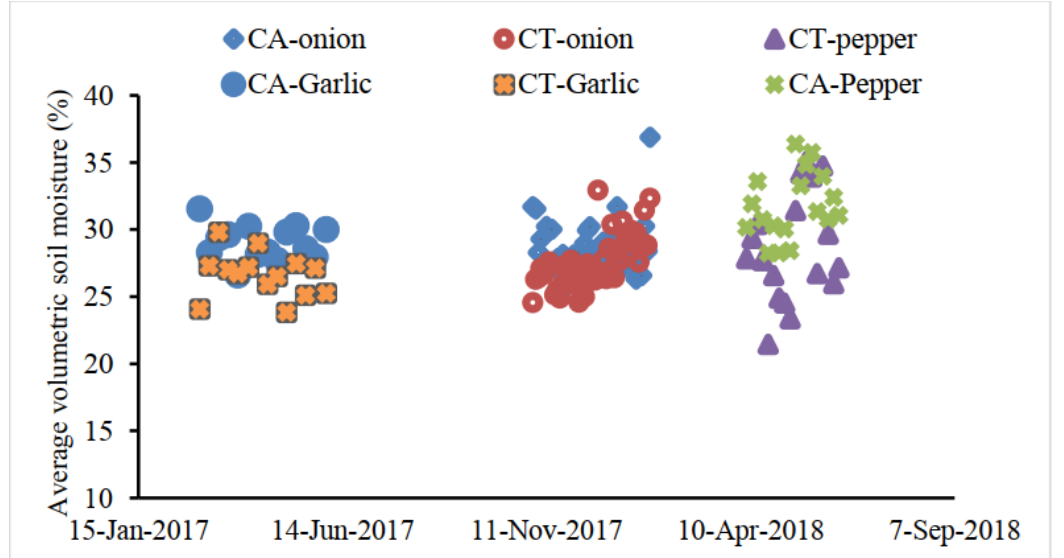
Figure 6. Average volumetric soil moisture content for CA management and CT practice in Dangishta experimental watershed under onion, garlic, and pepper experiment.